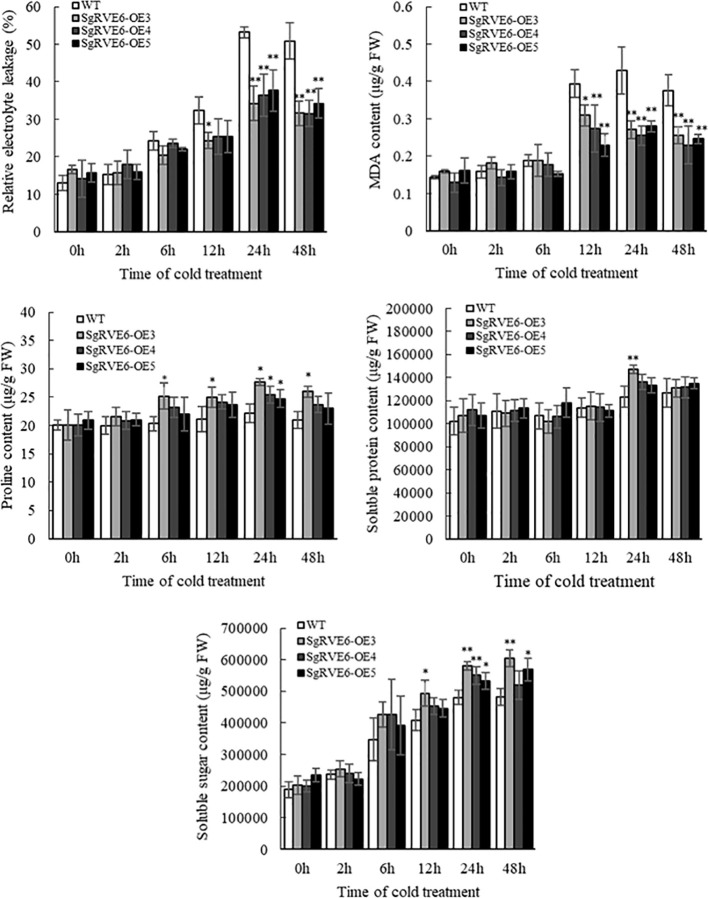
Physiological variations of SgRVE6 over-expressing transgenic (SgRVE6-OE3, SgRVE6-OE4 and SgRVE6-OE5) and wild-type (WT) tobacco under normal and cold conditions. (A) Relative electrolyte leakage. (B) MDA content. (C) Proline content. (D) Soluble protein content. (E) Soluble sugar content. The physiological measurements were represented as means ± SD of three sample replicates. * and ** above the columns indicated significant difference at P<0.05 and P<0.01 with WT.